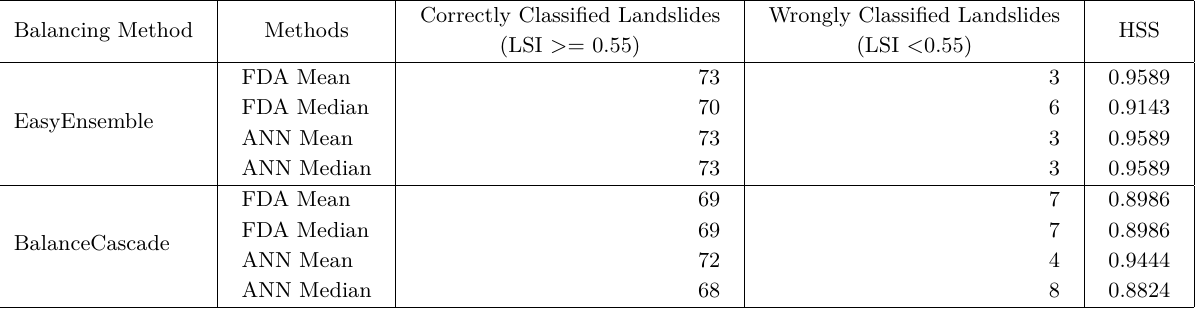
Table 5. Accuracy assessment of FDA and ANN on balanced data using Recall for total 2743 pixels in 76 landslides from 2013 to